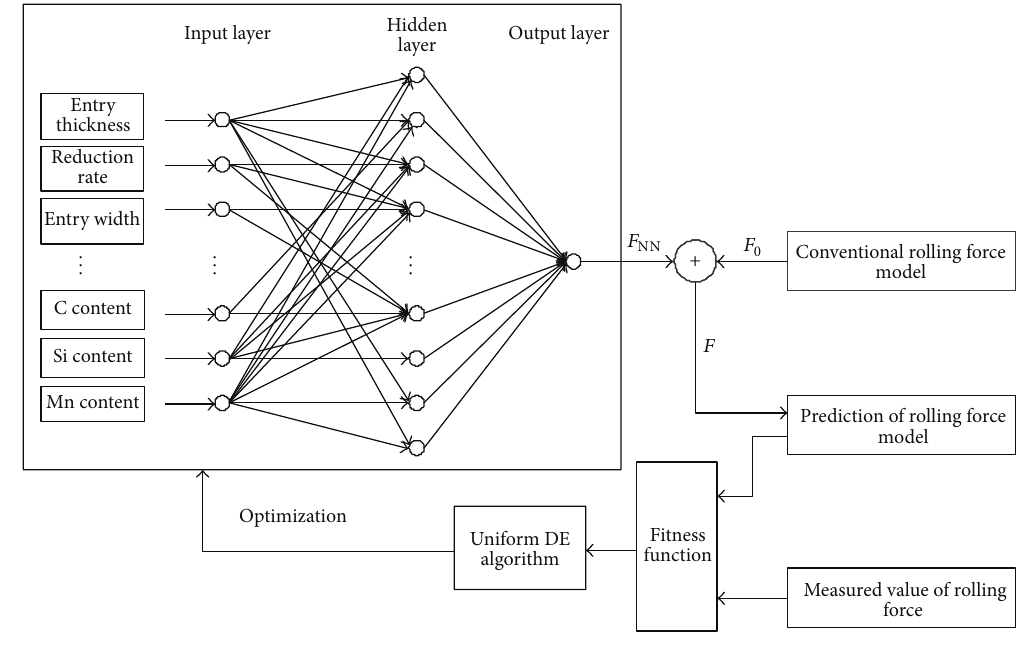
Figure 4: Schematics of uniform DE algorithm optimizing neural network.